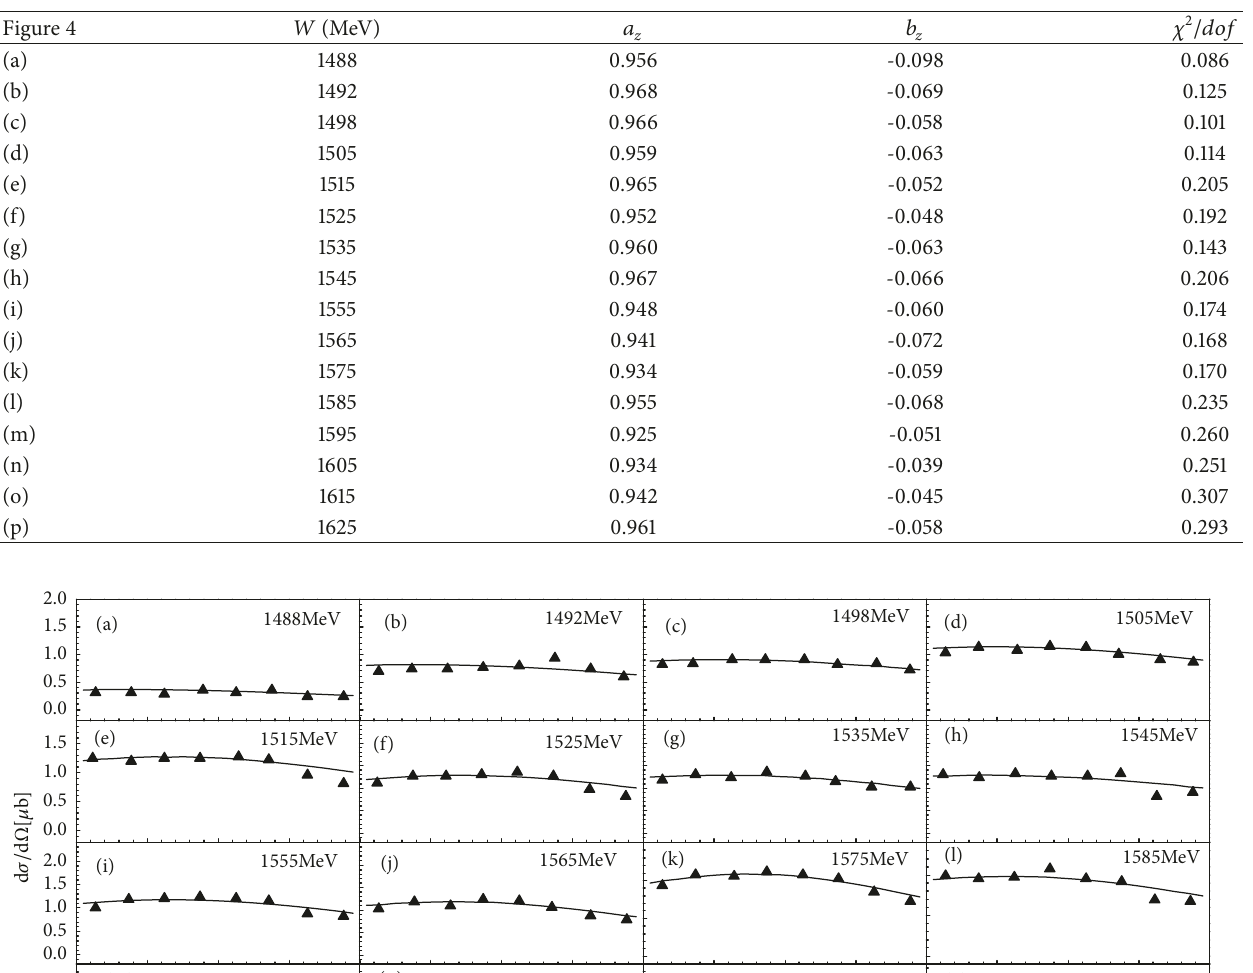
Table 4: Values of 𝑎 𝑧 and 𝑏 𝑧 taken in Figure 4 model results.